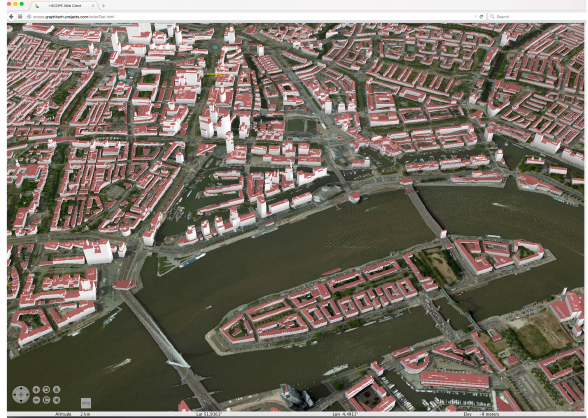
Figure 2 3D Model of the city of